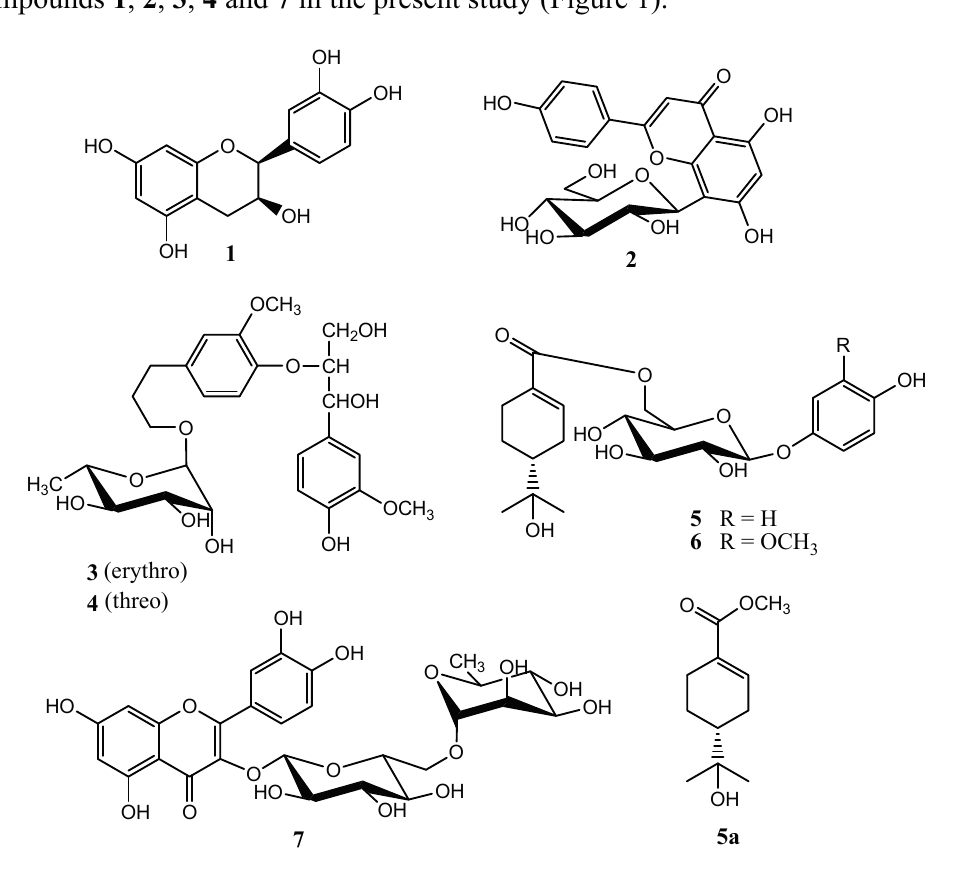
Figure 1. Chemical structures of compounds 1 – 7